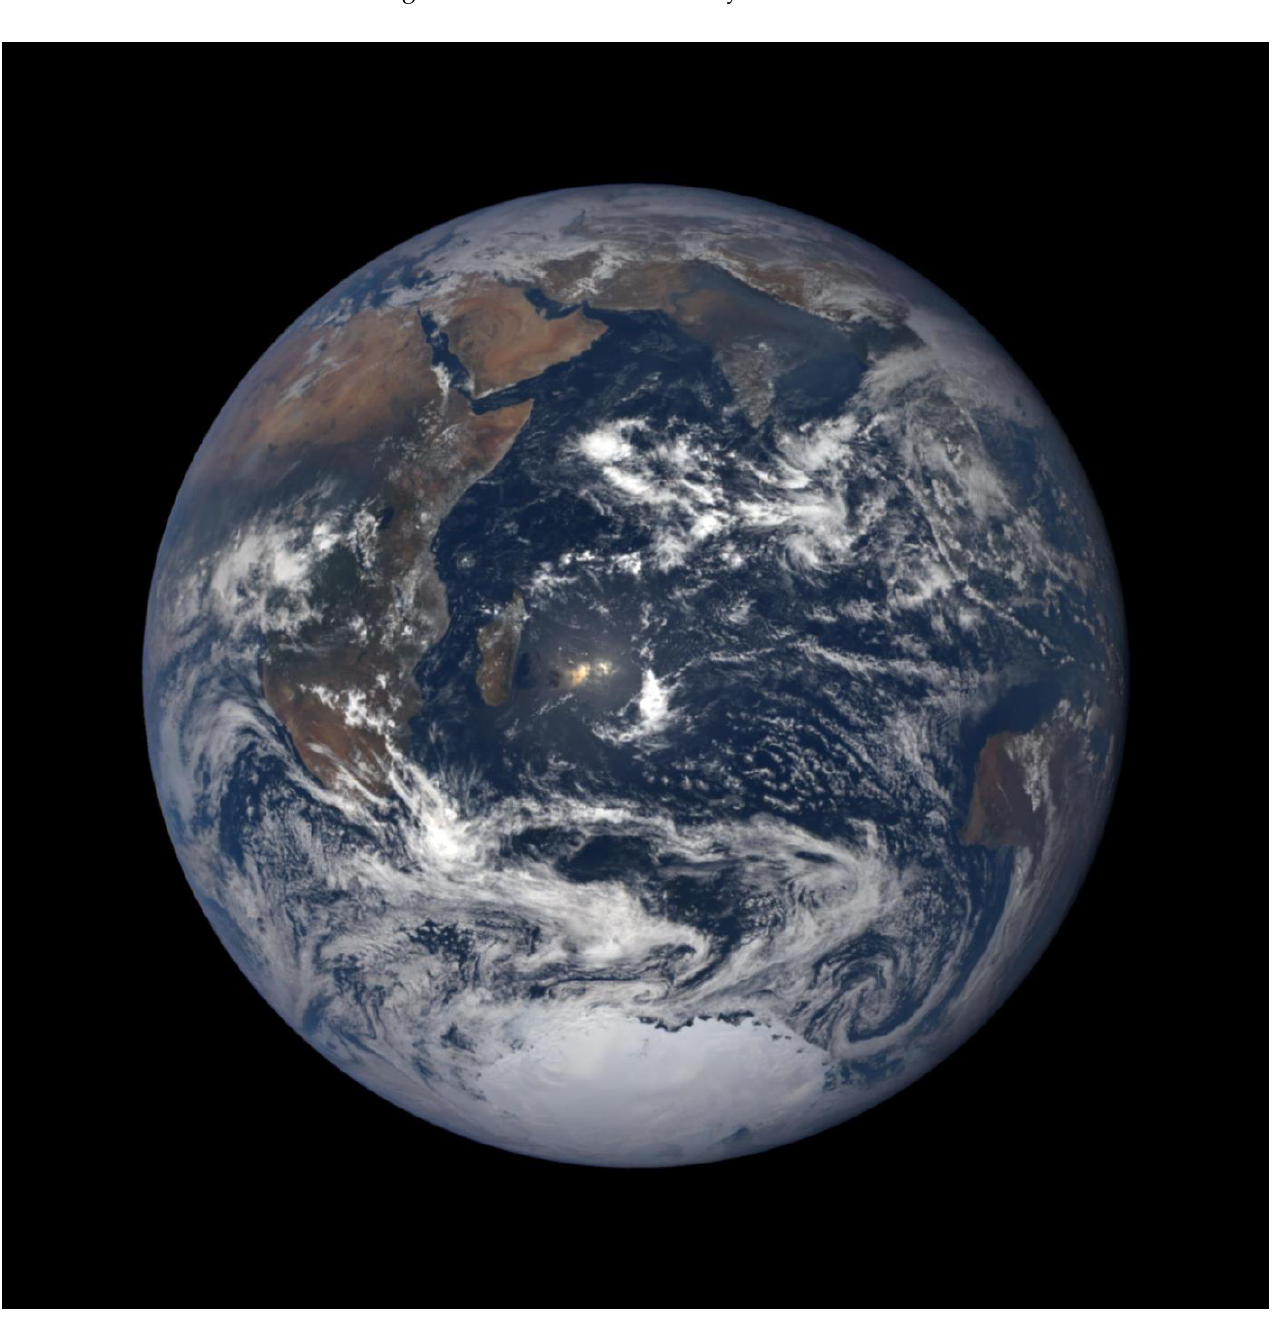
Figure 2. False colour composite of whole Earth disk captured from L1 by DSCOVR-EPIC on 7 December 2018. Note the view similarity with Figure 1 and the terrestrial storms.